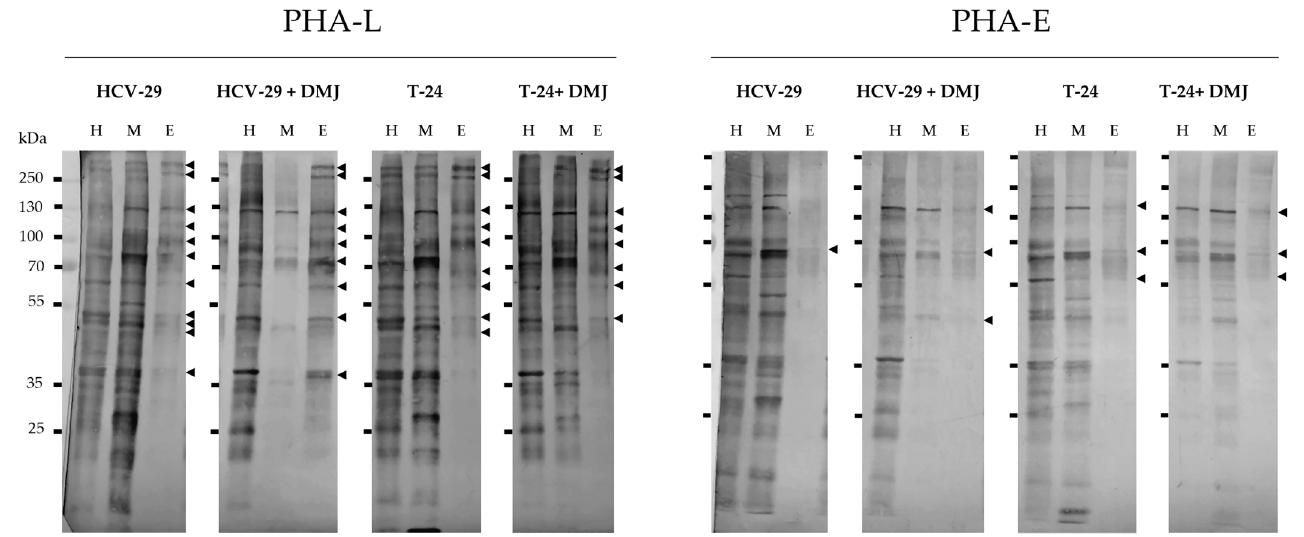
Figure 3. Detection of glycoproteins possessing β 1,6-branched tri- and/or tetraantennary complex type N-glycans (PHA-L-positive) and bisecting GlcNAc bound to the core mannose of complex type N-glycans (PHA-E-positive). Results of lectin blotting with PHA-L and PHA-E are shown in the figure. Controls with the competitive sugars are shown in Supplementary Data (Figure S1). The major specific bands were indicated on the right with arrowheads. H, the whole cell protein extract; M, the membrane fraction; E, the ectosomal fraction.